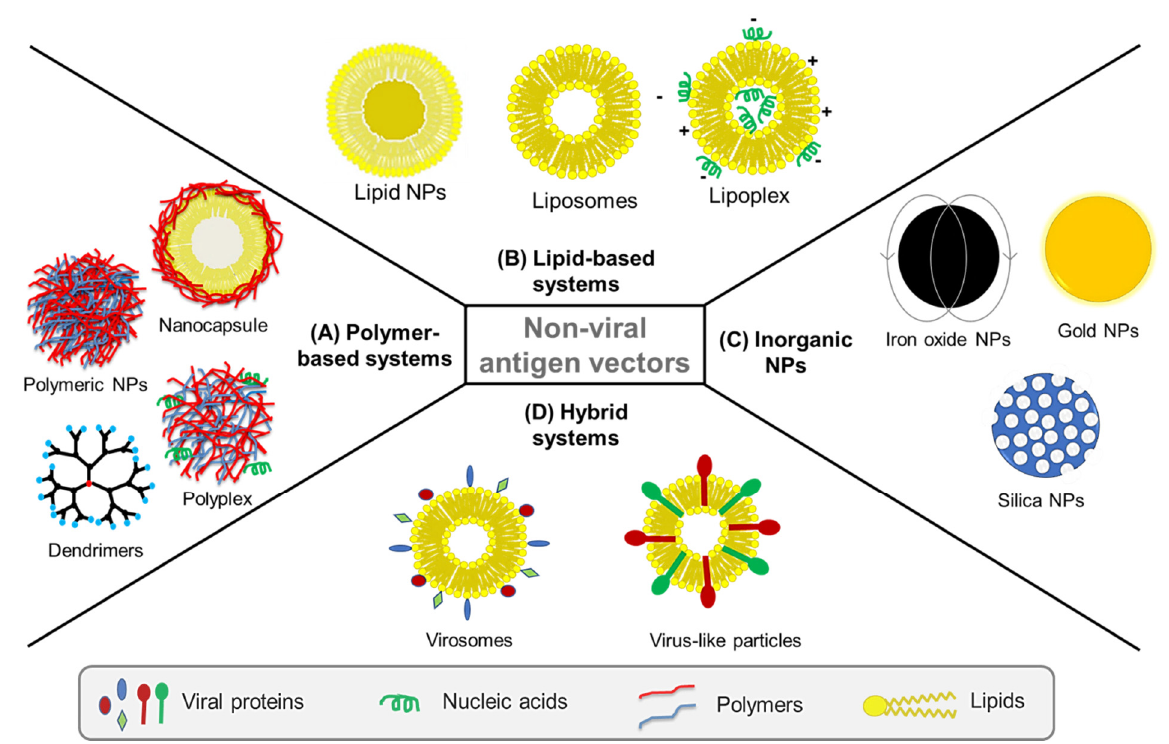
Figure 3. Nonviral vectors used for delivery of vaccines against viruses are classified into: ( A ) polymer-based systems such as polymeric nanoparticles (NPs), polyplexes, polymeric dendrimers and polymeric nanocapsules, ( B ) lipid-based systems such as liposomes, lipid NPs and lipoplexes, and ( C ) inorganic NPs such as iron oxide, gold, and mesoporous silica NPs. In addition to nonviral vectors, ( D ) hybrid systems such as virosomes and virus-like particles (VLPs) have been also developed to combine nonviral systems like liposomes with viral elements, for instance decorating liposomes with viral glycoproteins to imbue the system with viral immunogenicity.